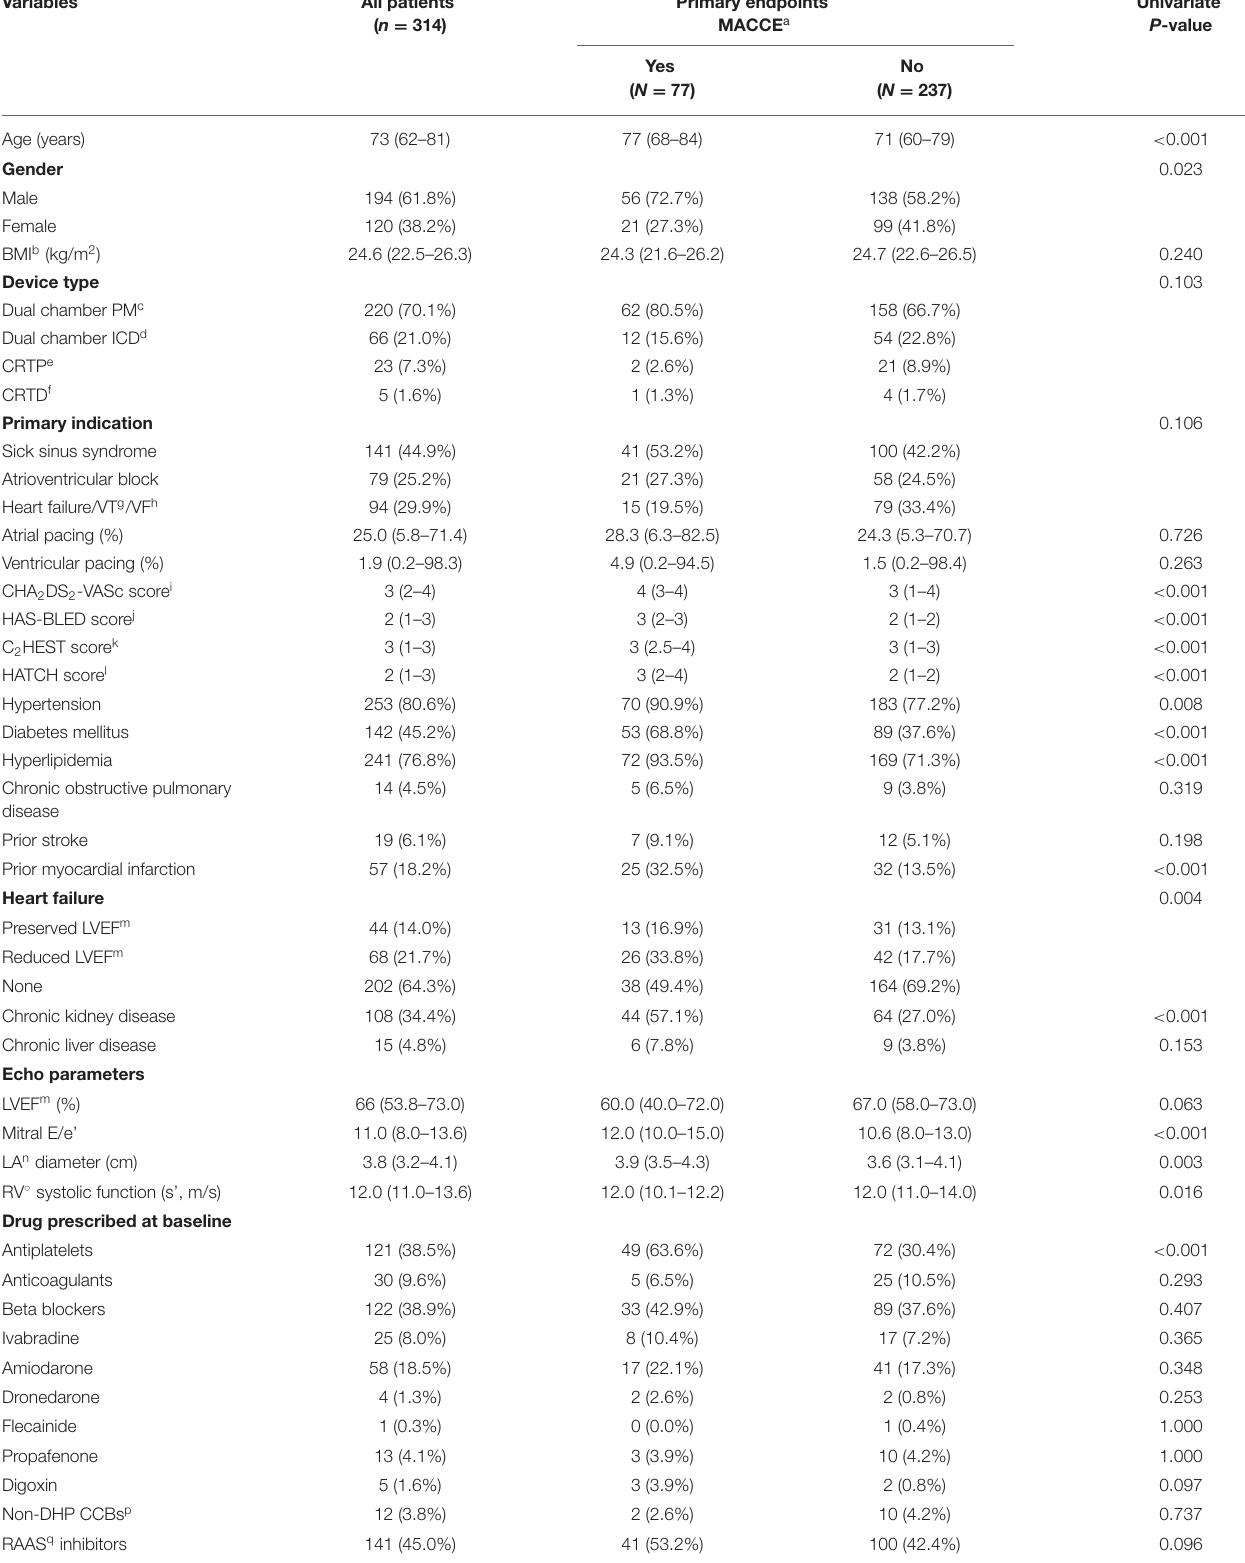
TABLE 1 | Baseline characteristics of the overall study group and with/without primary endpoints.